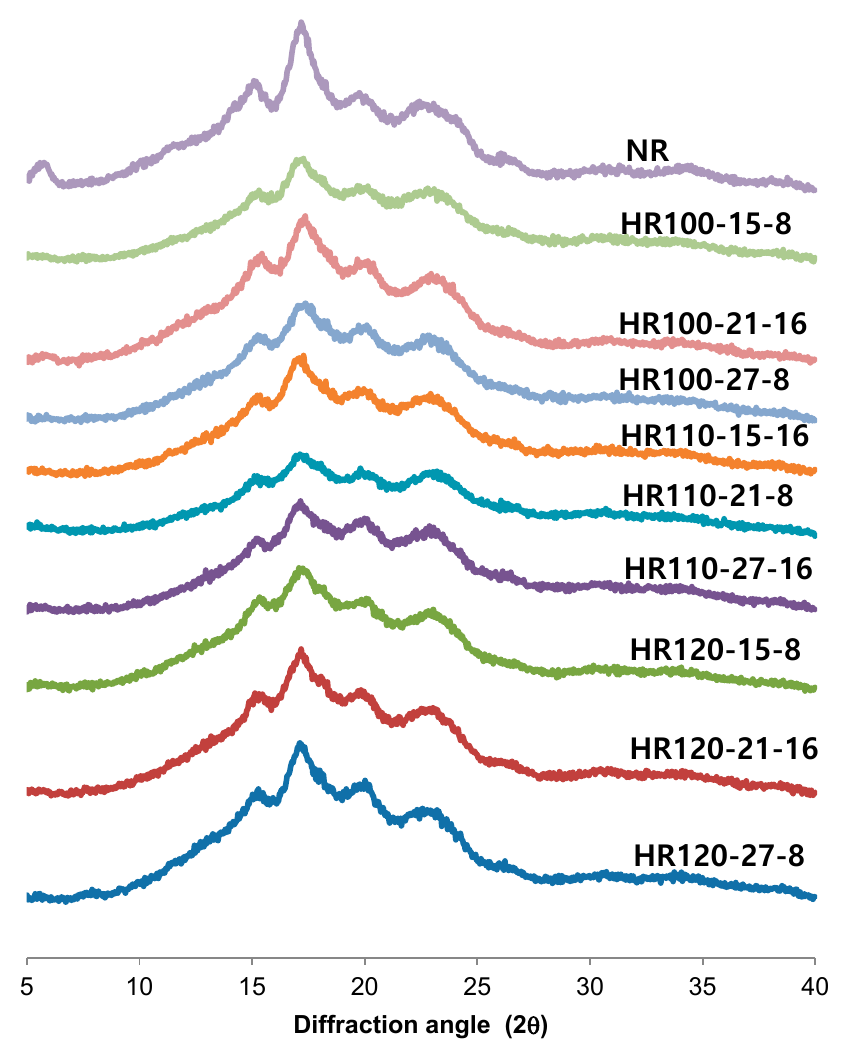
Figure 3. XRD patterns of native and heat–moisture treated rice starches. NR: native rice starch, HR: heat–moisture treated rice starch, 100, 110 and 120: heat–moisture treatment temperature, 15, 21 and 27: moisture content, 8 and 16: heat–moisture treatment time.